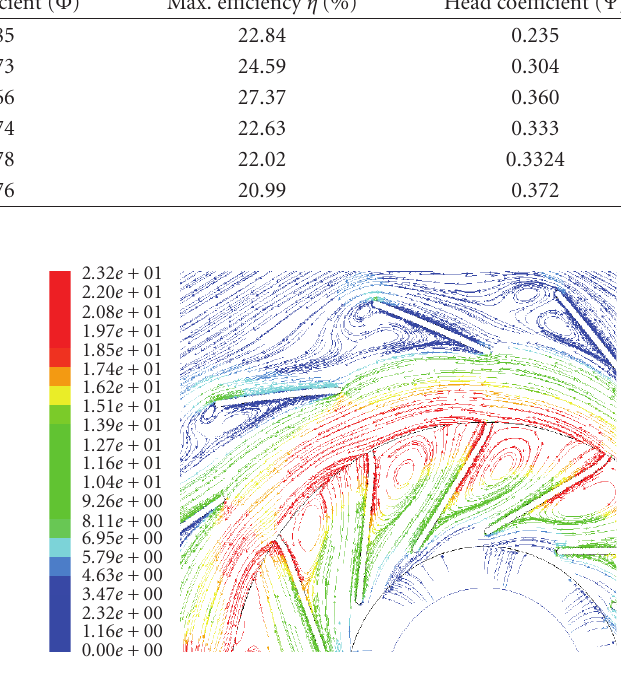
Figure 10: Relative velocity plot for configuration E (radial gap ratio = 0.25).